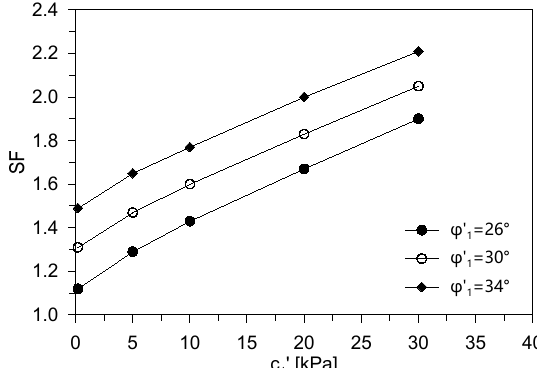
Figure 7. Safety factor SF as a function of the intercept cohesion c ′ 1 , for different values of the shear strength angle φ′ 1 (26°, 30° and 34°) in the case of homogeneous foundation soils. Figures 8 – 10 report the values of the safety factor calculated as a function of geomet- rical properties variable z i /H, with variation in the different shear strength parameters for both the foundation soil and the weak layer (see Table 1).